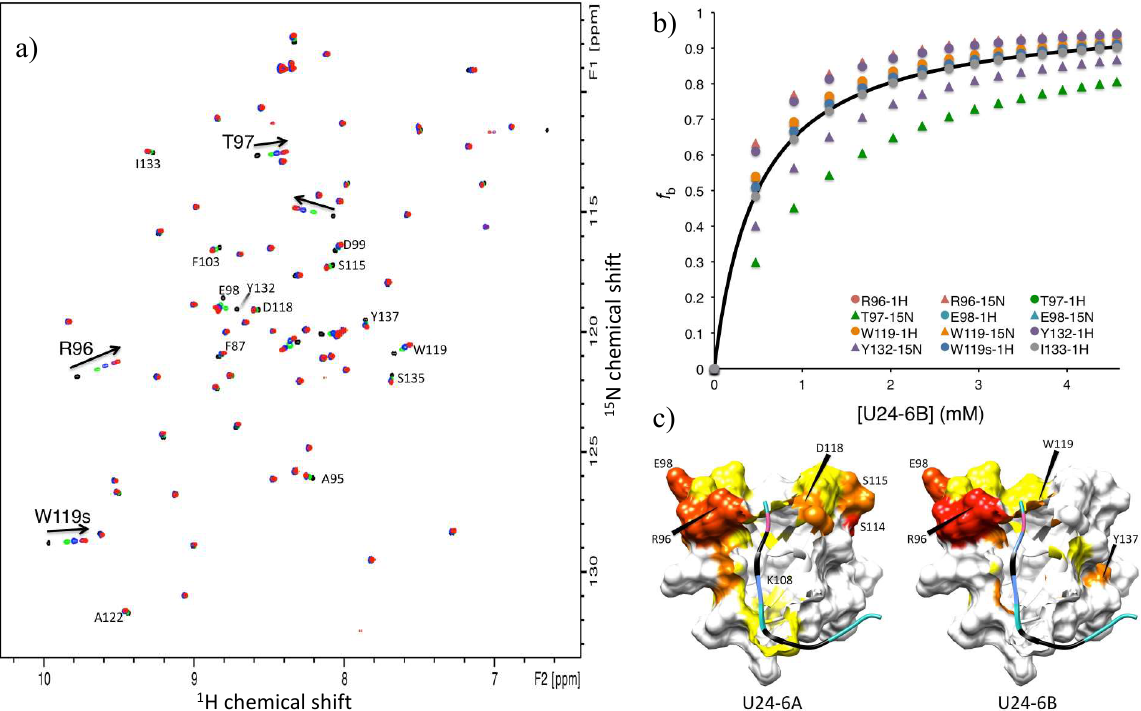
Figure 3. ( a ) Overlay of 2D 1 H- 15 N HSQC spectra of 0.2 mM 15 N-labelled Fyn-SH3 in 10 mM sodium phosphate, 10% D 2 O, 0.5 mM benzamidine, and 0.1% sodium azide (pH 6.0), recorded at 25 °C using a Bruker Avance III 600 MHz NMR, as a function of increasing U24-6B peptide concentration: (black) 1:0, (green) 1:2, (blue) 1:4, (purple) 1:8 and (red) 1:13 Fyn-SH3/U24-6B molar ratio. Most perturbed resonances (with the exception of four) could be assigned, as designated by the labels indicating residue type and number found next to the peaks (“s” indicates side-chain). ( b ) Fraction bound as a function of U24-6B peptide concentration (symbols, as indicated in the legend). The curve represents the calculated values of fraction bound for a K d = 0.5 ± 0.2 mM. ( c ) Chemical shift perturbations mapped onto model 4 of 1A0N.pdb, i.e., Fyn-SH3 bound to PI3-kinase peptide 2. For U24 ligands, Pro is in black, Arg in light blue, Asp in pink and the PxxP motif is represented as an edged ribbon. The color codes for the chemical shift perturbations are: ∆𝛿 (cid:3041)(cid:3042)(cid:3045)(cid:3040) = 0.80 − 1.00 in red, ∆𝛿 (cid:3041)(cid:3042)(cid:3045)(cid:3040) = 0.60 − 0.79 in orange red, ∆𝛿 (cid:3041)(cid:3042)(cid:3045)(cid:3040) = 0.40 − 0.59 in orange, ∆𝛿 (cid:3041)(cid:3042)(cid:3045)(cid:3040) = 0.20 − 0.39 in yellow and values < 0.20 in white, where ∆𝛿 (cid:3041)(cid:3042)(cid:3045)(cid:3040) = ∆𝛿 ∆𝛿 (cid:3040)(cid:3028)(cid:3051) ⁄ , with ∆𝛿 = (cid:3495)(𝛿 (cid:3029)(cid:3042)(cid:3048)(cid:3041)(cid:3031),(cid:3009) − 𝛿 (cid:3028)(cid:3043)(cid:3042),(cid:3009) ) (cid:2870) + 0.1(𝛿 (cid:3029)(cid:3042)(cid:3048)(cid:3041)(cid:3031),(cid:3015) − 𝛿 (cid:3028)(cid:3043)(cid:3042),(cid:3015) ) (cid:2870) and ∆𝛿 (cid:3040)(cid:3028)(cid:3051) being the largest value found for a given residue i.